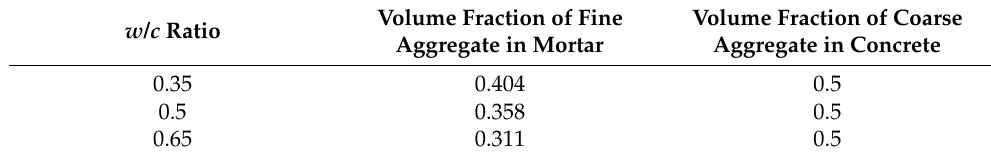
Table 3. The parameters for